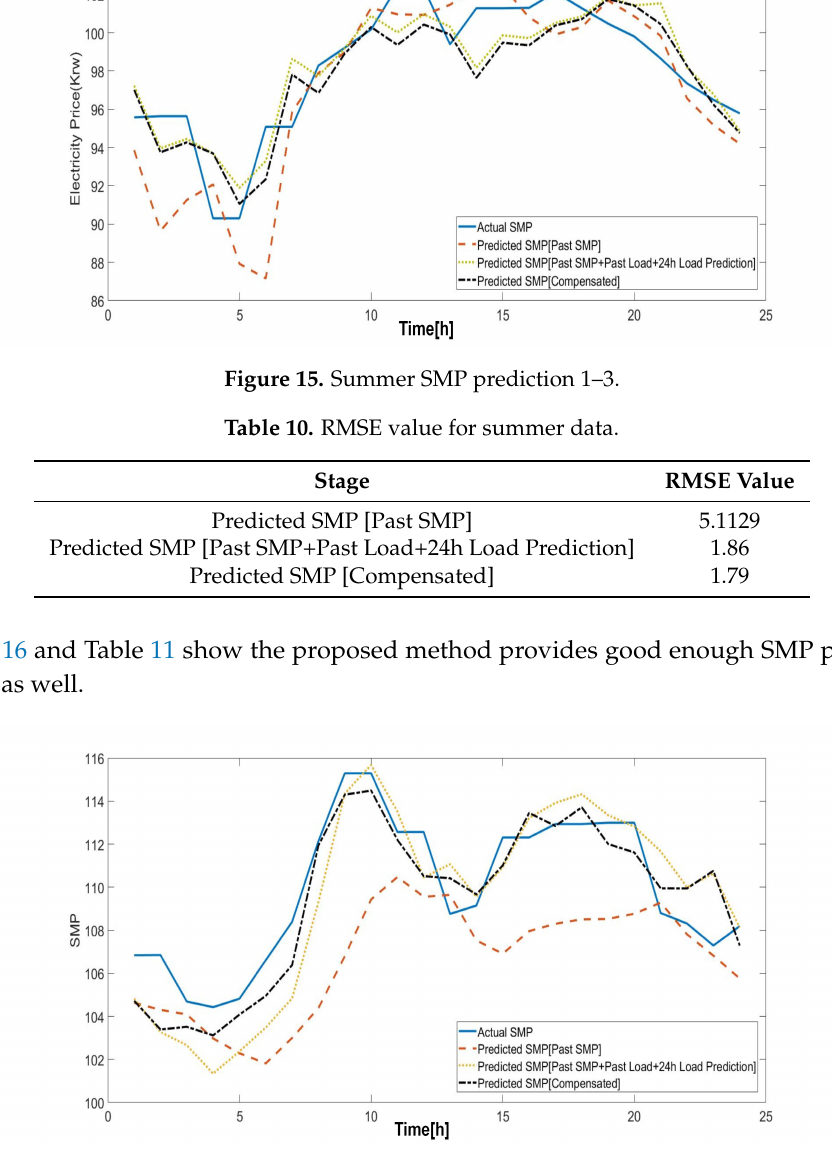
Figure 16. Winter SMP prediction. Table 11. RMSE value for winter